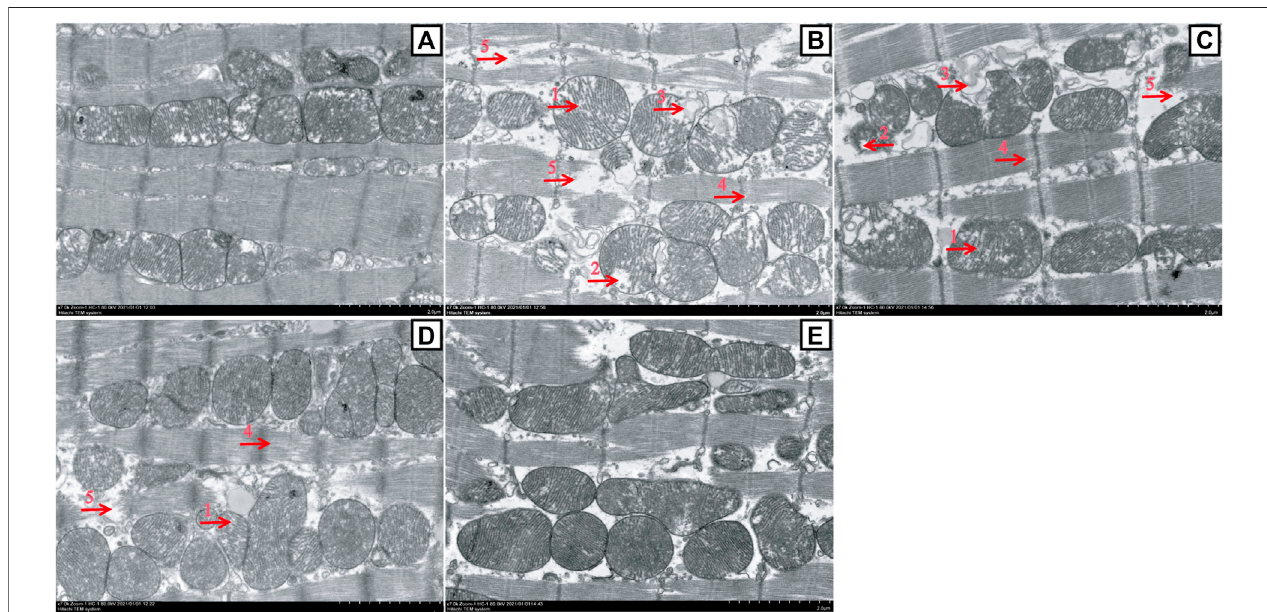
FIGURE7| ChangesinmyocardialmitochondrionultrastructurebetweentheATOgroupandHEStreatmentgroups(scalebar (cid:1) 2.0 μ m,magni fi cation:7000 × ).A toErepresenttheCONT, ATO,HES L ,HES H ,andHESgroups,respectively.TEMimagesshowtheultrastructurechangesofmyocardialmitochondria:themitochondria were swollen, and the cristal space was enlarged (arrow 1); the crest became short or dissolved and disappeared (arrow 2); the cristae disappeared, and the mitochondria were vesicular (arrow 3); the space between myo fi laments was enlarged (arrow 4); and myo fi laments broke, dissolved and disappeared (arrow 5).